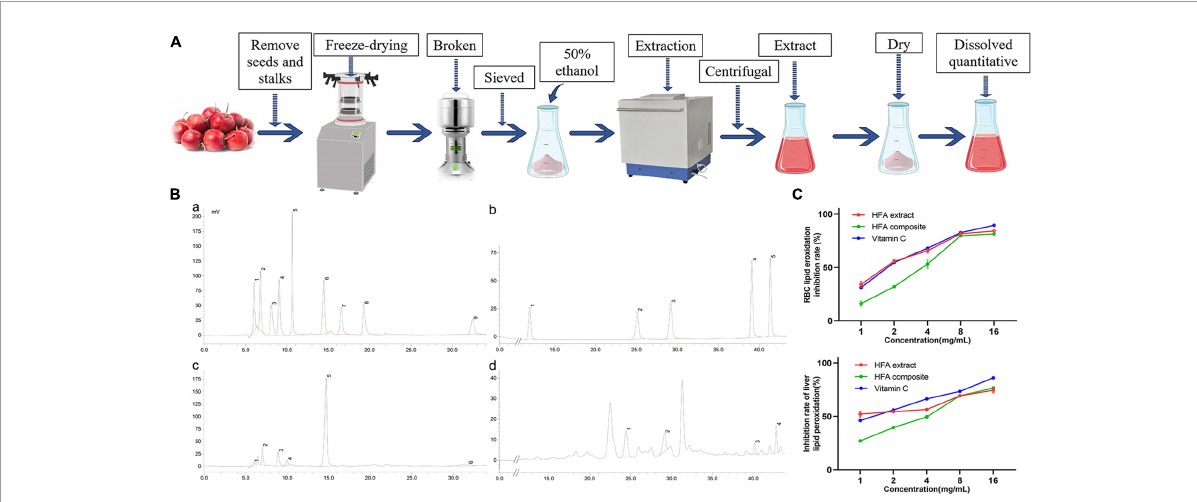
FIGURE1 Identification of hawthorn fruit acids (HFA) and the in vitro antioxidant capacity of HFA. (A) Flow chart of HFA preparation; (B) high-performance liquid chromatogram; a. Peaks 1–9 are OxA, TA, PA, L-MA, AA, CiA, SA, D-MA, GA; b. Peaks 1–5 are GA, PA, ChA, CaA, P-CA, FA; c. Peaks 1–6 are OxA, TA, L-MA, AA, CiA, GA; d. Peaks 1–4 are ChA, CaA, P-CA, FA; (C) in vitro lipid peroxidation analysis. Data express mean ± SD ( n =